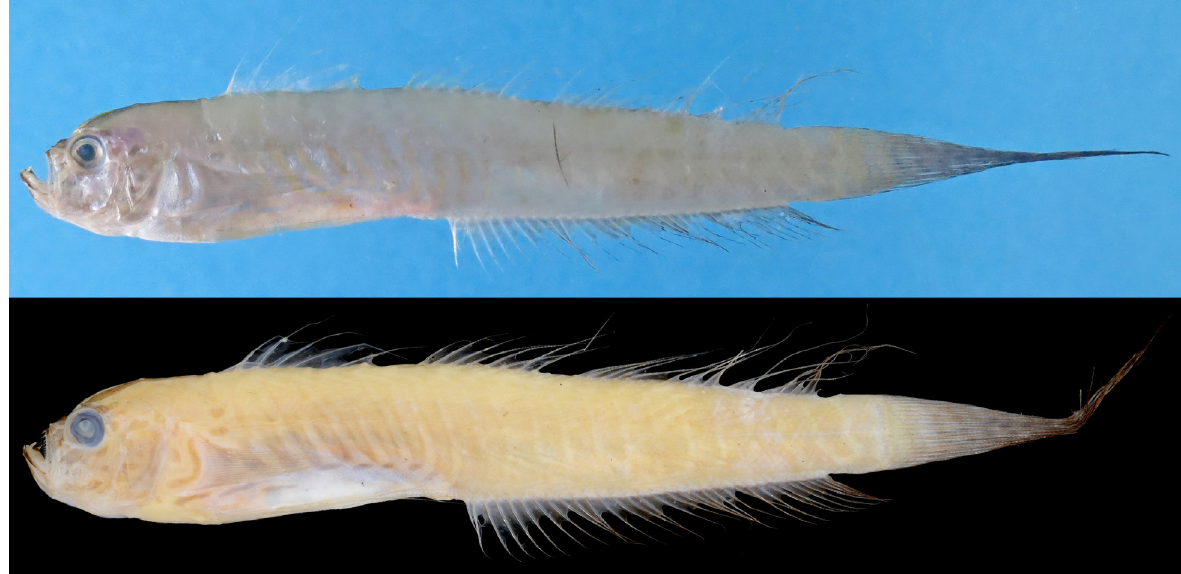
Fig. 1. Fresh (upper) and preserved (lower) specimen of Oxymetopon cyanoctenosum from south-western Taiwan; NMMB-P29845, 99.2 mm